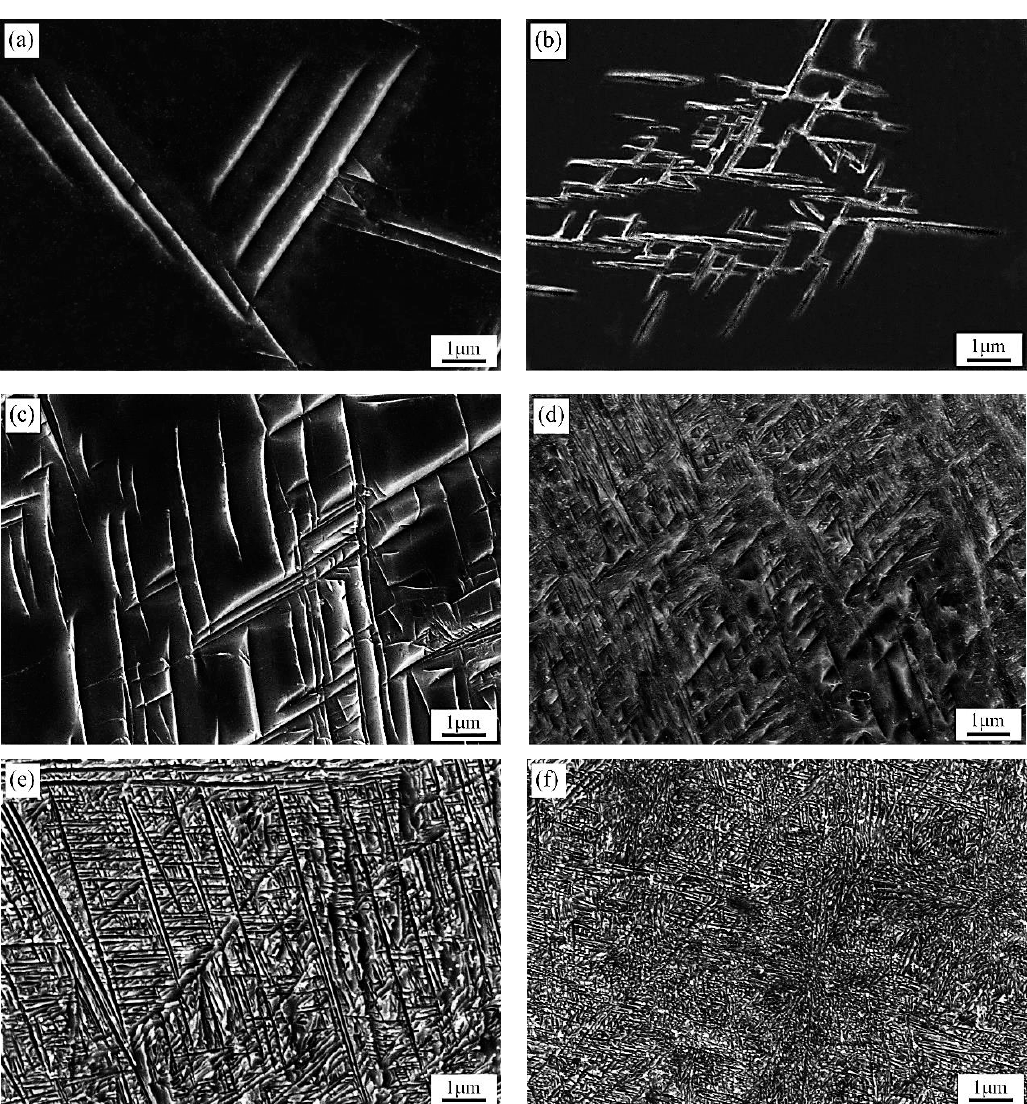
Figure 7. SEM micrographs of Ti–3.5Al–5Mo–4V alloy that was solution-treated at ( a , c , e ) 850 °C and ( b , d , f ) 1050 °C, then isothermally aging-treated at 500 °C for ( a , b ) 45 min, ( c , d ) 2 h, and ( e , f ) 16 h.